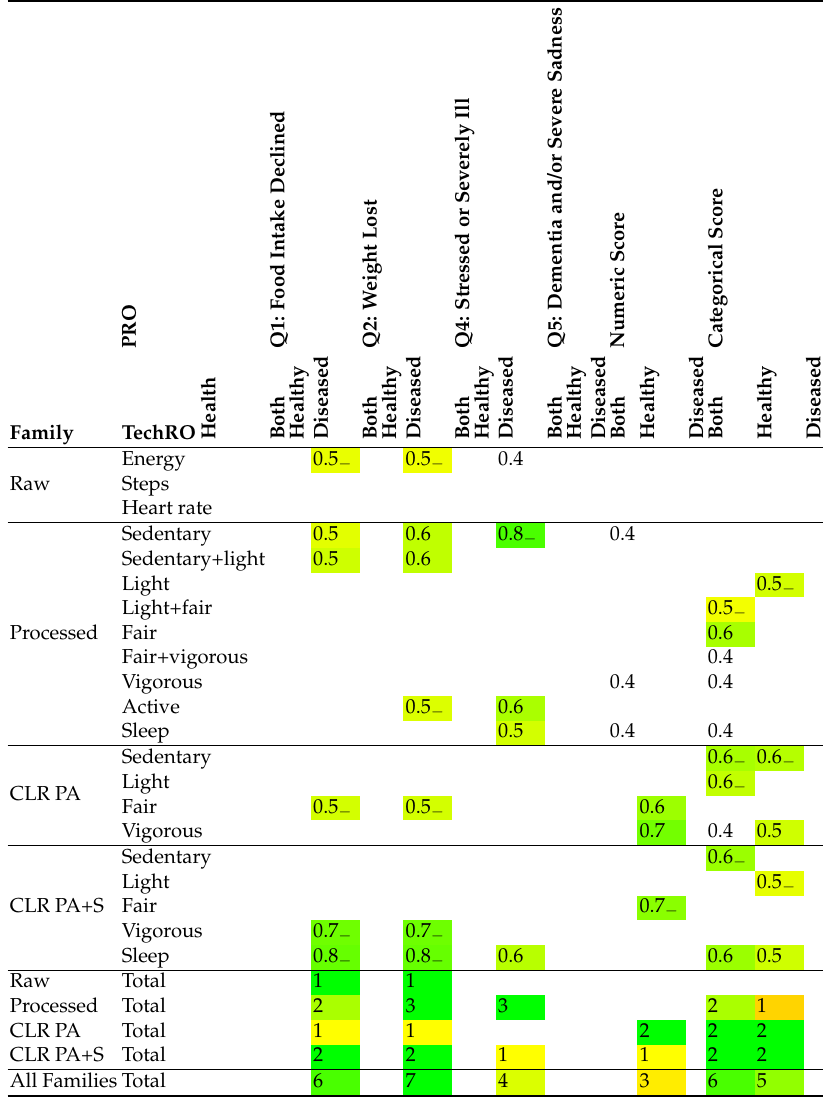
Table A17. Correlation coefficient (Spearman r S ) between TechROs from Fitbit (rows) and PROs of Nutrition on the SelfMNA scale (columns).